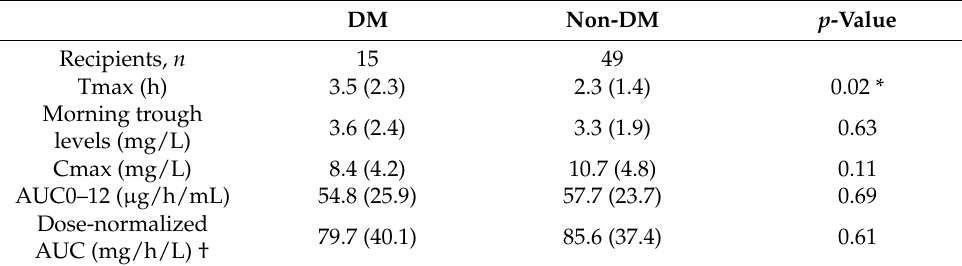
Table 3. Pharmacokinetic profile of mycophenolic acid at 3 weeks after transplantation. DM Non-DM p -Value Recipients, n 15